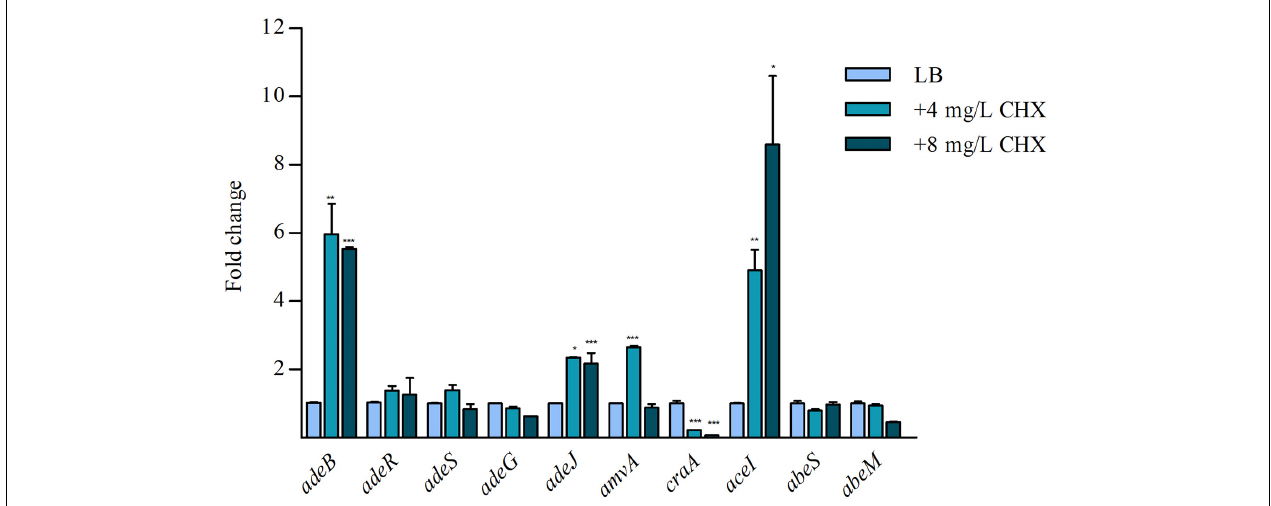
FIGURE 2 | RT-qPCR assay of adeB, adeR , adeS , adeG , adeJ , amvA , craA , aceI , abeS, and abeM expression in the presence of LB and 4 mg/L and 8 mg/L CHX. Relative number of transcripts of each gene was normalized in each condition and calculated using the 2 - (cid:49)(cid:49) ct method compared to the expression level in LB control. The mean + standard deviation of relative number of transcripts is shown for each gene. All experiments were performed in triplicate. p -values were calculated using ANOVA (* p < 0.05; ** p < 0.01; *** p < 0.001).